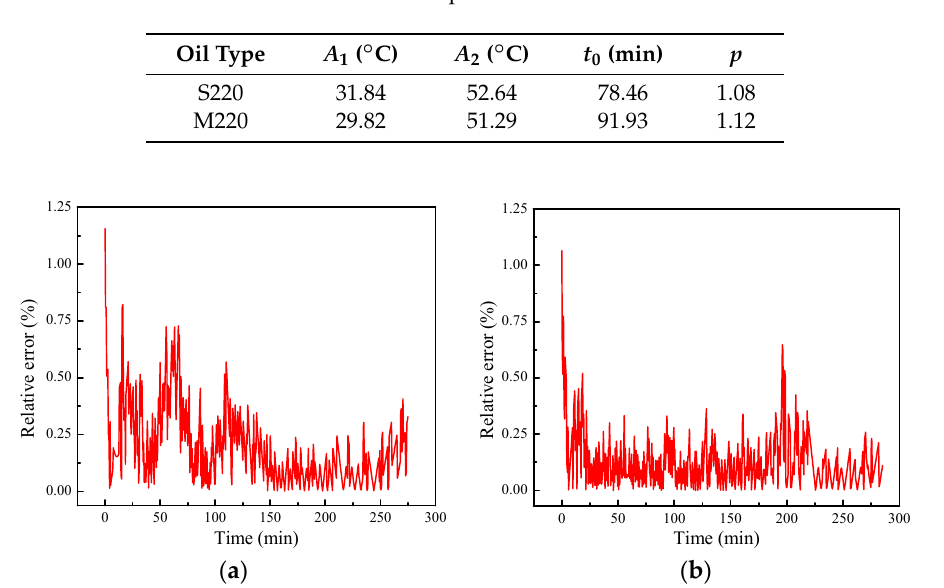
Table 6. Fitted values of related parameters of different kinds of oil.